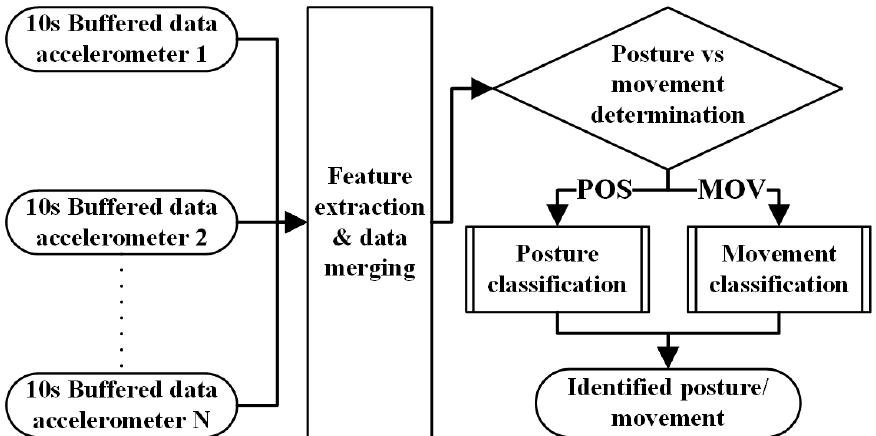
Figure 4. Schematic representation of the identification algorithm, which is applicable for any number and combination of sensors. To distinguish postures from movements in general, the standard deviation of the norm was utilized. This same feature was used to classify a specific movement. Finally, the mean value of the x- and z -axis of each sensor was used as a feature to classify a specific posture.